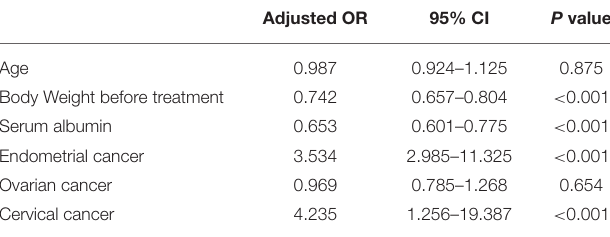
TABLE 3 | Adjusted multivariable logistic regression analysis of factors predicting moderate and severe malnutrition in gynecological cancer patients. Adjusted OR 95% CI P